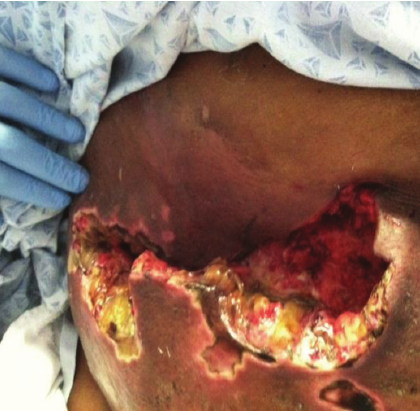
Figure 4: Anterior abdominal wall with erythema and edema prior to